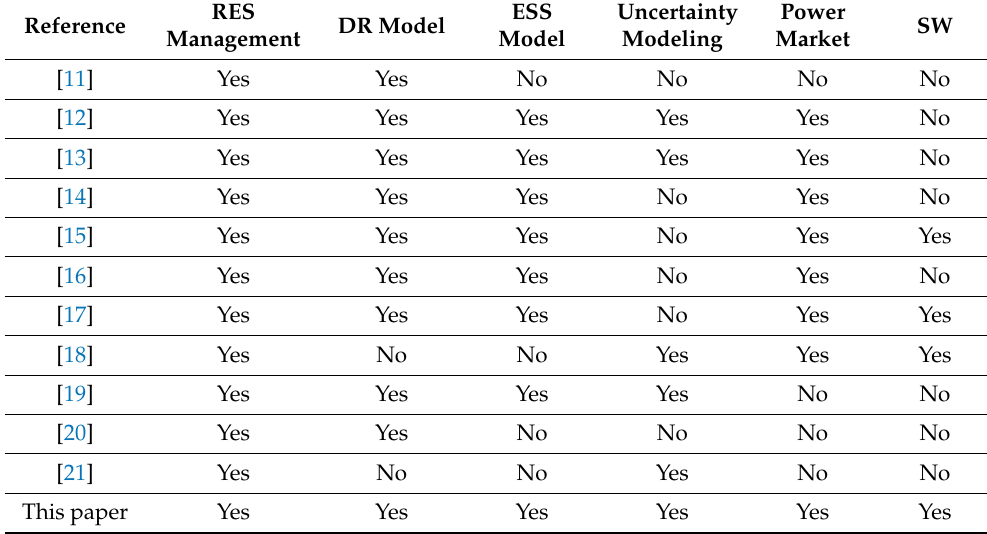
Table 1. Comparison of the proposed method with existing